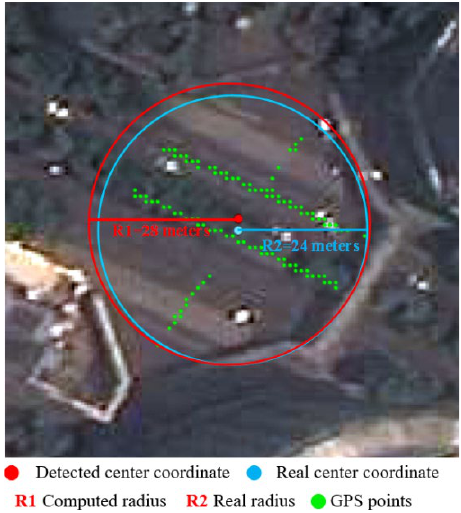
Figure 10. Radius computing of a road intersection.